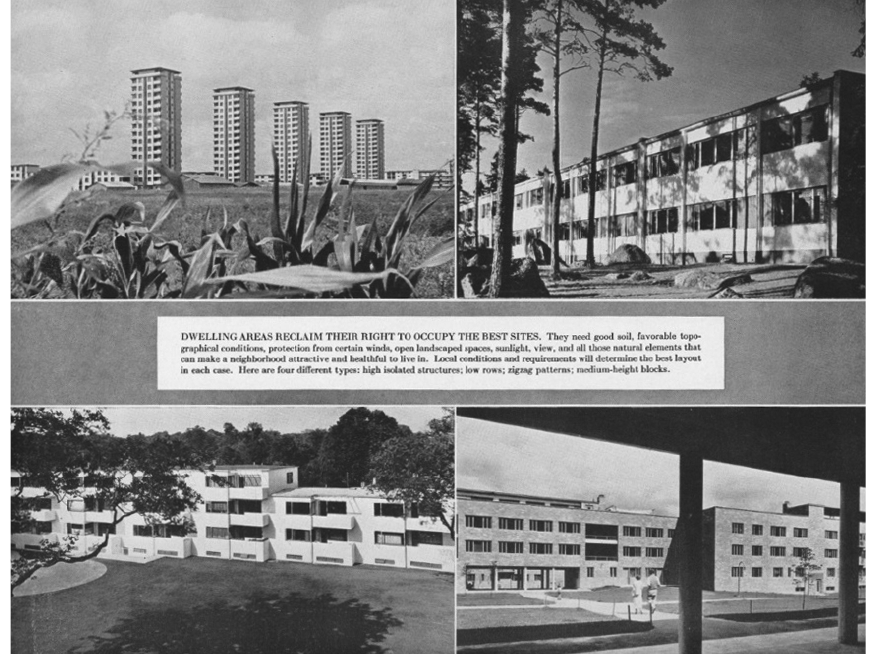
Figure 8. Examples of housing by CIAM members. Top left: Beaudouin, Lods, and Prouvé, Cité de la Muette, Drancy, near Paris, 1936. Top right: Alvar Aalto, Sunila Type B rowhouses, 1936. Bottom left: Arne Jacobsen, Bellavista Flats, Bellevue, Denmark, 1931–34. Bottom right: Stonorov and Kastner, Carl Mackley Houses, Philadelphia, 1931. Source: Sert